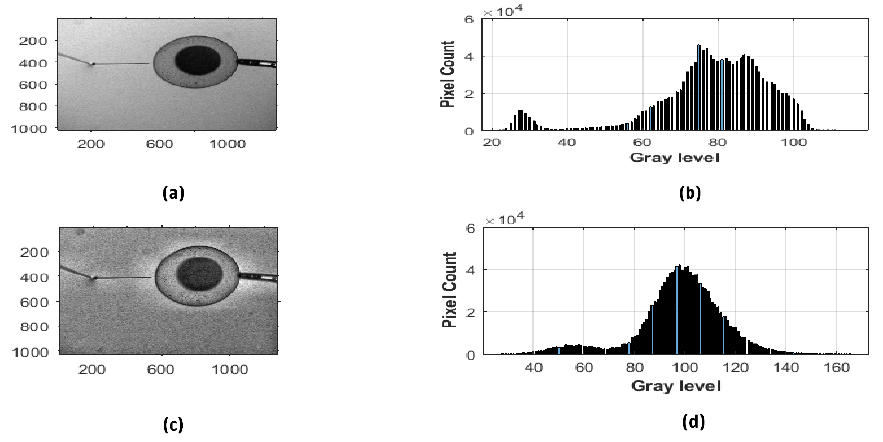
Figure 3. Enhancement of gray-scale intracytoplasmic sperm injection (ICSI) image by the contrast-limited adaptive histogram equalization (CHALE) method and its histograms ( a ) Original ICSI image; ( b ) histogram of the original ICSI image; ( c ) contrast-limited adaptive histogram equalization (CLAHE) image; ( d ) histogram of CHALE image.